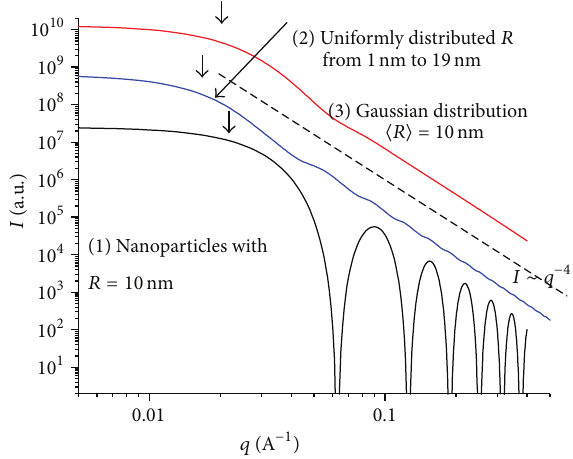
Figure 2: Results of calculation of neutron scattering in the Born approximation.